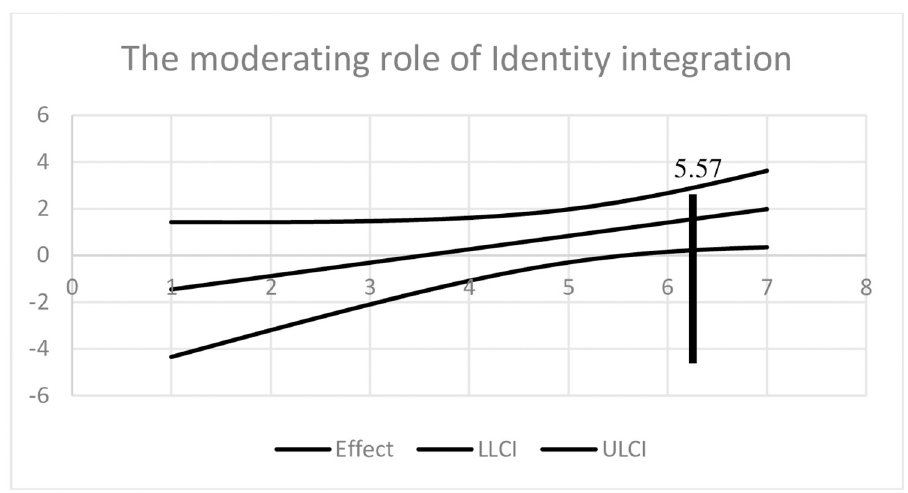
Fig 2. Floodlight analysis: The moderating role of identity integration (Experiment 3). Notes: The graph was drawn on the basis of a "floodlight" analysis (Disatnik and Steinhart 2015; Spiller, Fitzsimons, Lynch Jr, and McClelland 2013) of the effect of identity integration on tendency toward consistent behavior. Confidence bands are also presented, and the Johnson-Neyman points are obtained at identity integration = 5.57 ( p =